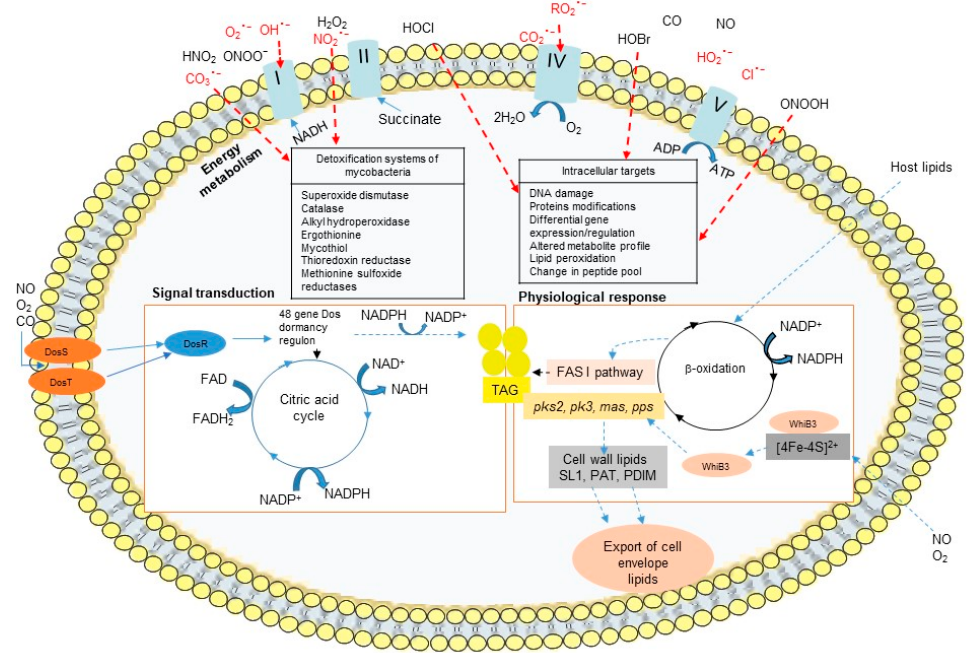
Figure 6. Mycobacterial stress sensors (adapted from [75]) Mammalian host cell generates radicals and gases as a mechanism to counter mycobacterial infection. M. tuberculosis senses these potentially damaging stresses and responds by adjusting its energy metabolism, physiology and signaling and counters the damage by detoxification processes. M. tuberculosis possesses sensing mechanisms such as the Dos dormancy regulon and the WhiB3 redox sensor detecting environmental gases and alterations in its intracellular redox state. The Dos regulon senses O 2 , NO, and CO through the DosS and DosT heme proteins which transduce the signal to DosR leading to the induction of 48-member Dos dormancy regulon. WhiB3 functions as a regulator of cellular metabolism, which responds to O 2 and NO through its Fe–S cluster and integrates it with intermediary metabolic pathways. WhiB3 is an intracellular redox regulator that dissipates reductive stress generated by utilization of host fatty acids through β -oxidation.